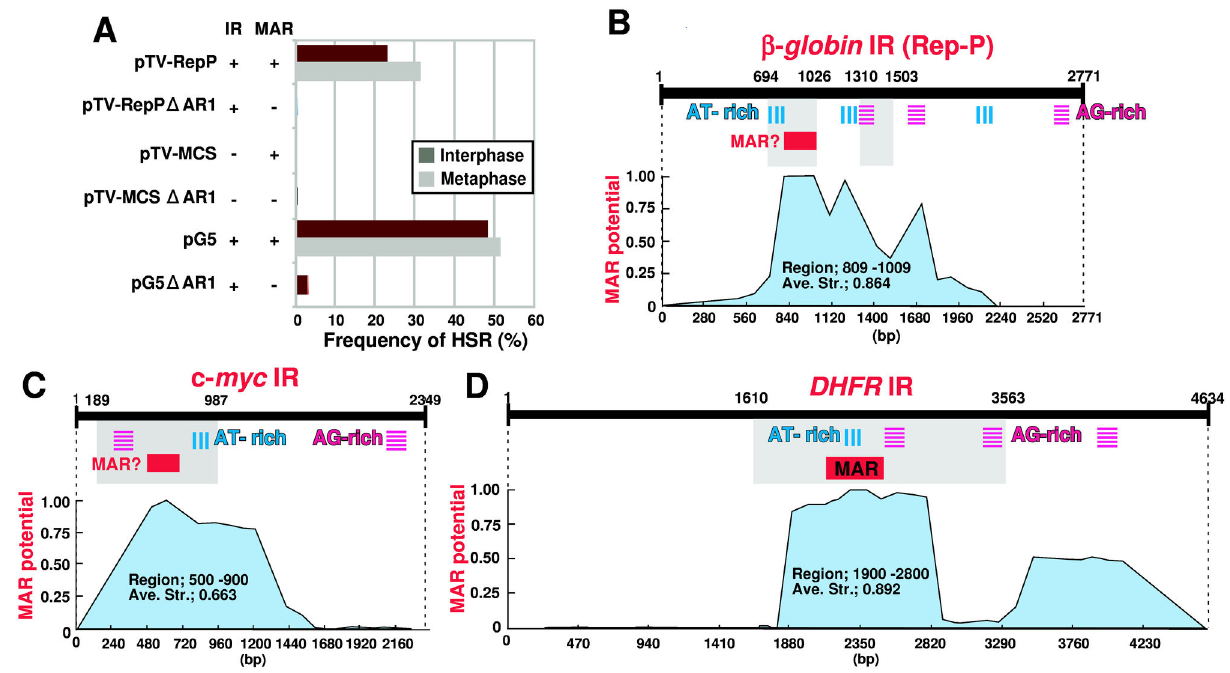
Figure 7. Requirement of MAR for HSR generation. A. To examine the effect of the AR1 MAR sequence of the vector plasmid, we removed it and constructed three new plasmids, pTV-Rep-P∆AR1, pTV-MCS∆AR1, and pG5∆AR1. We transfected plasmids with or without the AR1 MAR into COLO 320DM cells, selected transfectants, and analyzed them by FISH. Frequency of HSR is plotted in the graph. B–D. The IR sequences from ß-globin Rep-P (B), c-myc (C), and DHFR (D) were analyzed using MAR-Wiz program, and the results (blue graph area) are shown. In each graph, regions with HSR-generation activity revealed by our previous study ( DHFR and c-myc; [18]) and this study (ß-globin) are shown as gray rectangle(s). AT-rich and AG-rich tracts are also indicated.